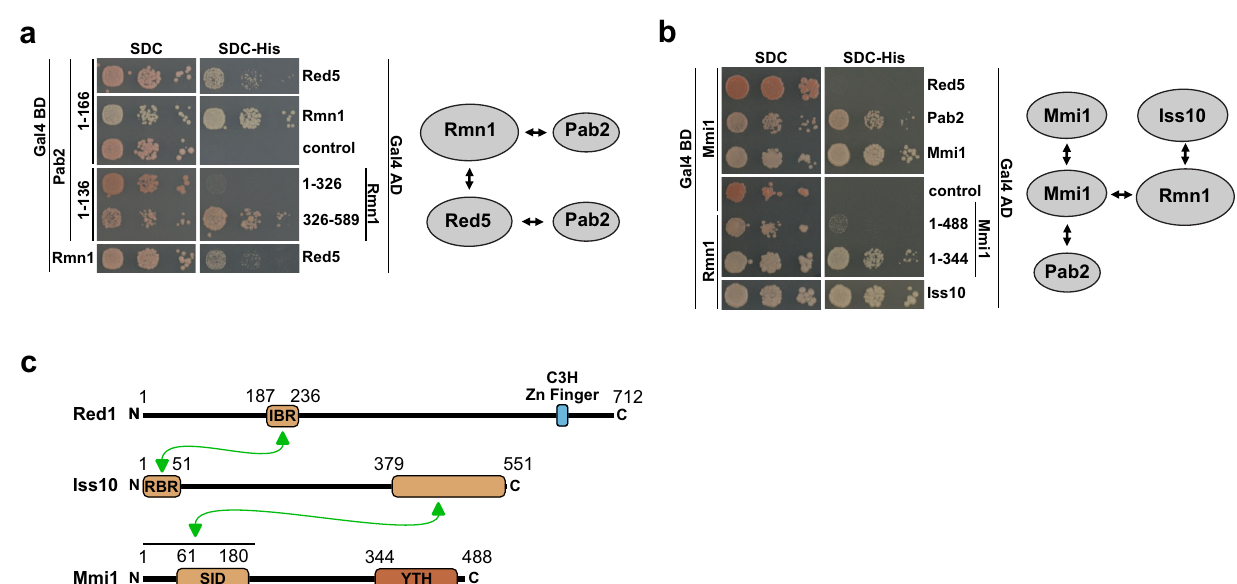
Fig. 2 Interaction analysis of Red5 – Pab2 – Rmn1 and Mmi – Iss10 submodules. a Y2H analysis identi fi ed interactions within the Red5 – Pab2 – Rmn1 submodule. b Y2H analysis identi fi ed interactions between the Iss10 – Mmi1 and Red5 – Pab2 – Rmn1 submodules. c Scheme summarizing the interactions of Red1, Iss10, and Mmi1. The minimal interacting regions identi fi ed in this study are depicted. IBR Iss10-binding region, RBR Red1-binding region, SID self-interaction domain, Gal4 BD Gal4 DNA-binding domain, Gal4 AD Gal4 activation domain, SDC-Leu-Trp (SDC) and SDC-Leu-Trp-His